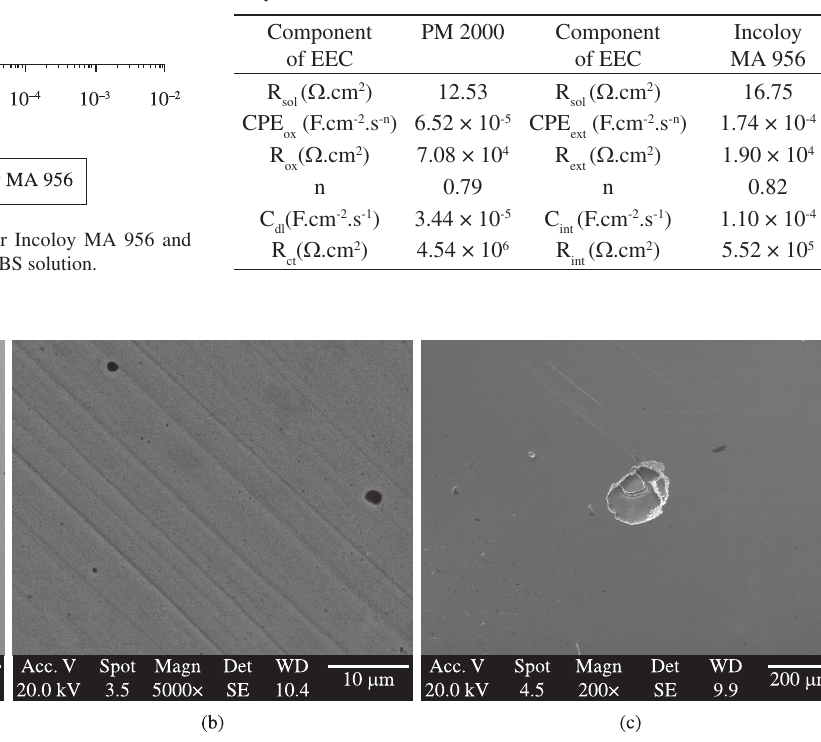
Figure 4. SEM micrographs of surface of the superalloys investigated after polarization tests. a) PM 2000; b) same at higher magnifications; and c) MA956, showing pits on the surface of the tested